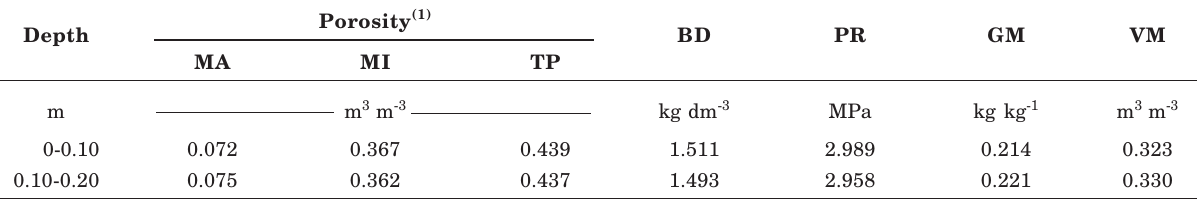
(1) MA: macroporosity, MI: microporosity, TP: total porosity, BD: bulk density, PR: penetration resistance, GM: gravimetric moisture, VM: volumetric moisture.